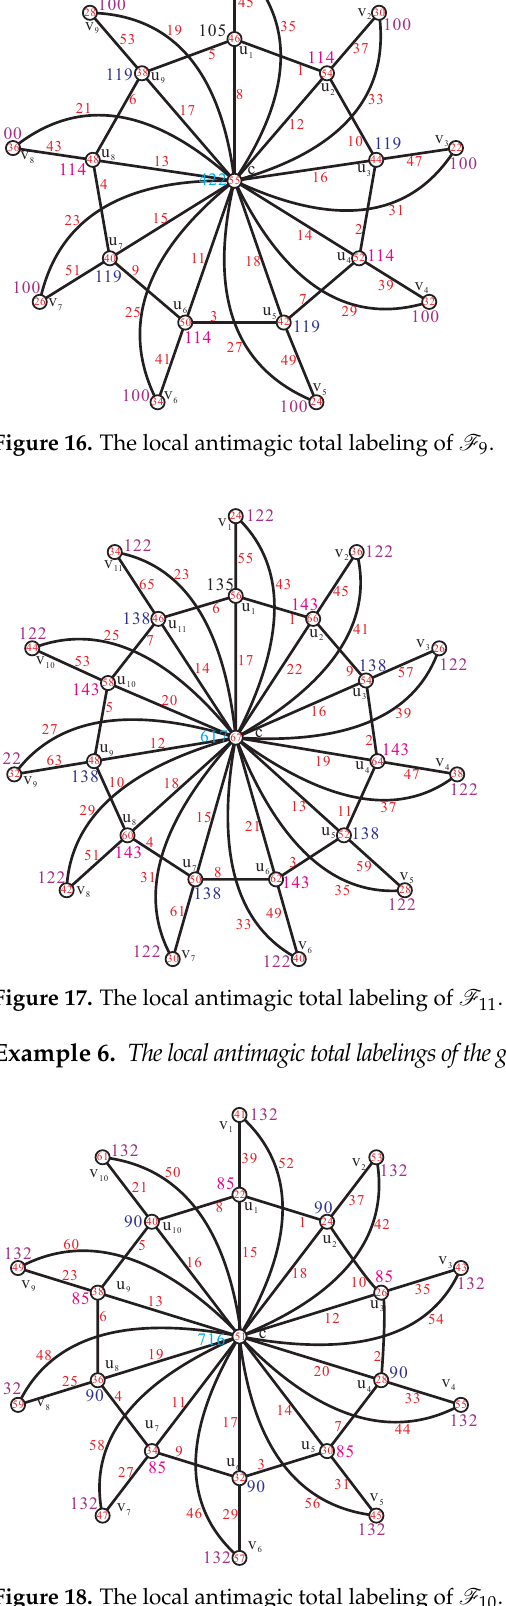
Figure 18. The local antimagic total labeling of F 10